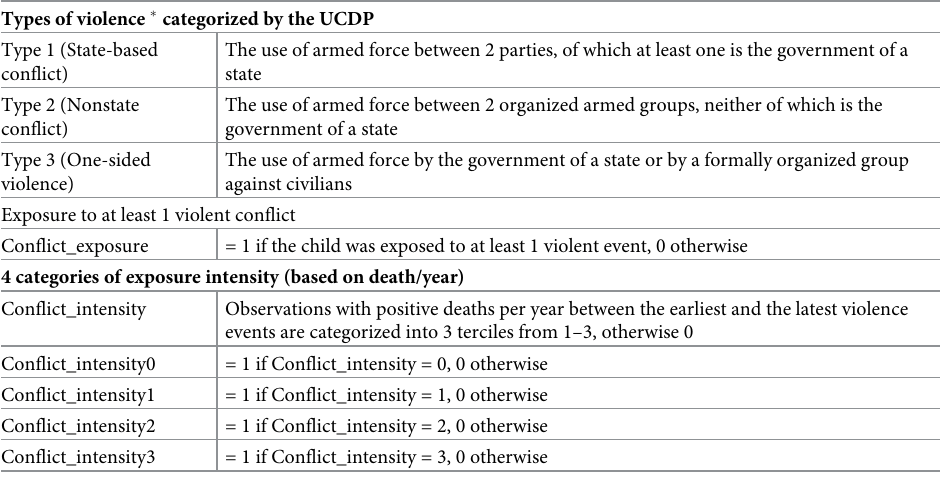
Table 1. Conflict variables and definitions.